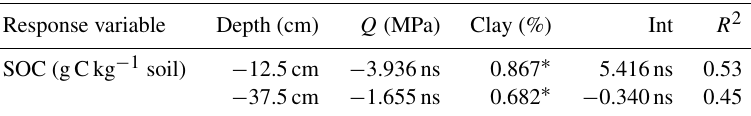
Table 4. Summary statistics of multiple linear regression models to explain soil organic carbon content as a function of penetration resistance and clay content (Eq. 3). ∗ indicates significant regression coefficients at p< 0 . 01, and ns indicates non-significant regression coefficients. R 2 represents multiple r -squared values.